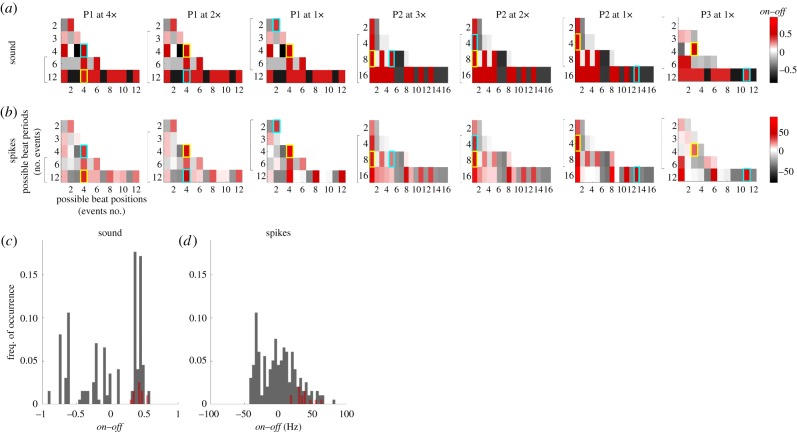
Exploration of on–off for all possible combinations of beat periods and beat positions. (a) Heat maps represent on–off for all possible combinations of beat grouping (y-axis) and beat position (x-axis) for each of the seven rhythmic sound patterns tested. Yellow and cyan boxes mark the most and second most common beat interpretations reported by human listeners, respectively. Brackets indicate those groupings whose theoretical tapping frequencies are in the range 0.5–4 Hz, the range within which beat is typically perceived [20]. (b) Same as panel a, but based on population firing rates. (c) All hypothetical on–off values for sound (grey) and the two most commonly perceived beat structures (red), pooled across the seven stimuli. (d) Same as panel c, but for population firing rates.